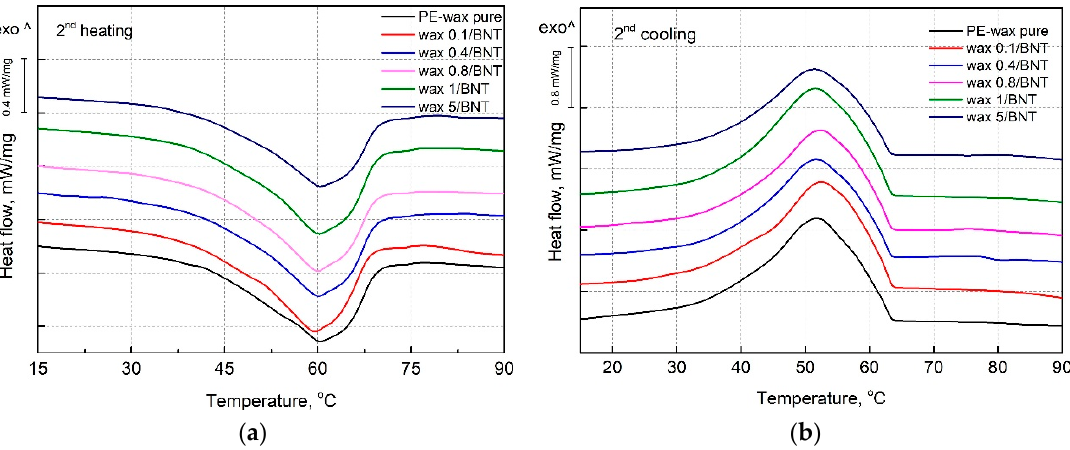
Figure 11. Differential scanning calorimetry (DSC) melting ( a ) and crystallization ( b ) curves of pure PE-wax filled with various amounts of the bentonite.